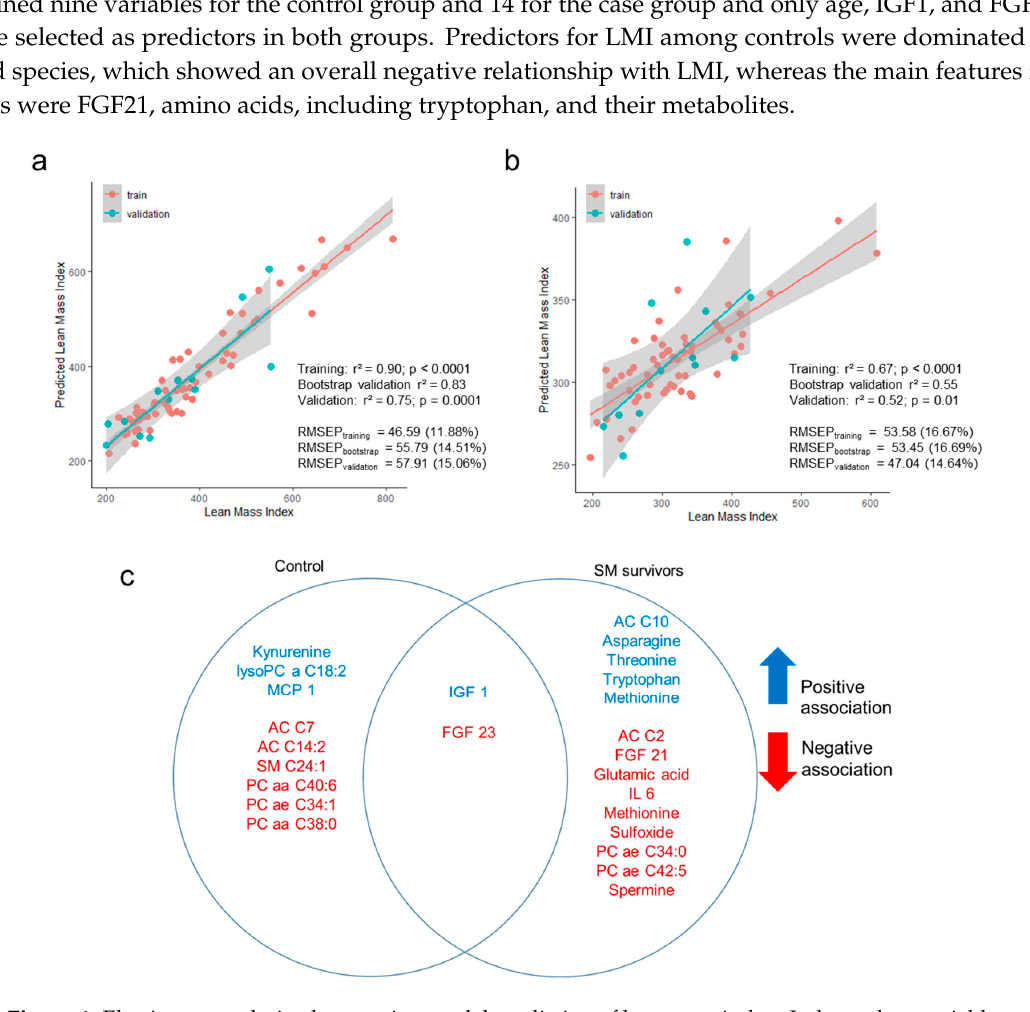
Figure 4. Elastic net regularized regression model prediction of lean mass index. Independent variables included age, sex, HIV status, 155 plasma metabolite concentrations, and 22 hormones. Correlation between observed lean mass index and predicted lean mass index among control ( a ) and SM survivors ( b ). Training set included 80% of the observations and the remaining 20% was used for external validation. RMSEP = root mean squared error of prediction, the numbers in parentheses indicate the percentage of mean lean mass index. Bootstrap validation of the training set was performed using 1000 iterations. ( c ) Metabolite and hormone features selected by the elastic net model. Features in blue are positively associated with lean mass while features in red are negatively associated.